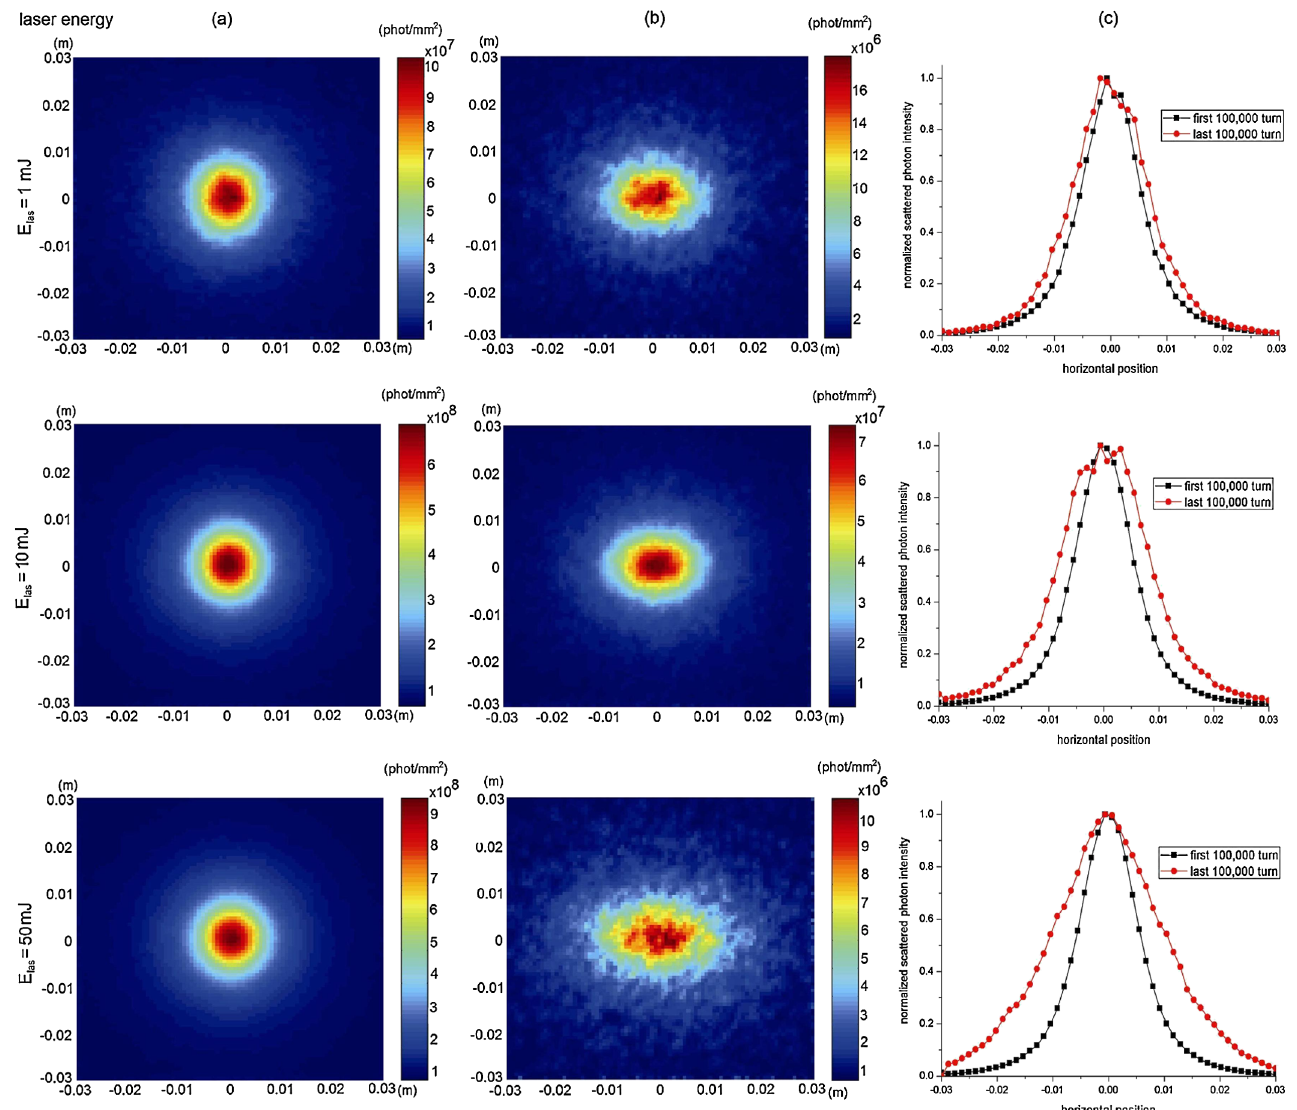
FIG. 7. (Color) The spatial distributions of the x-ray photon in the CCD placed 1.5 m away from the IP with different laser energies. The subfigures in column (a) are the spatial distributions of the x-ray photon intensity for the first 100 000 turns; subfigures in column (b) are those for the last 100 000 turns. The subfigures in column (c) are the normalized spatial distributions of the photon intensity for the first and last 100 000 turns. The growth in the light spot horizontal size indicates the growth in horizontal emittance of the electron